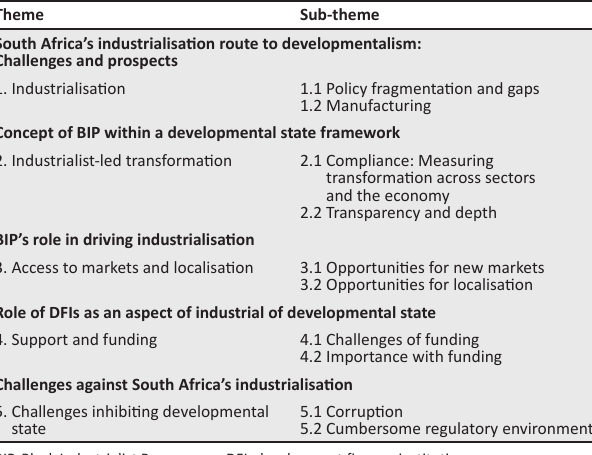
TABLE 3: Study thematic findings. Progress of the developmental state looking at the BIP